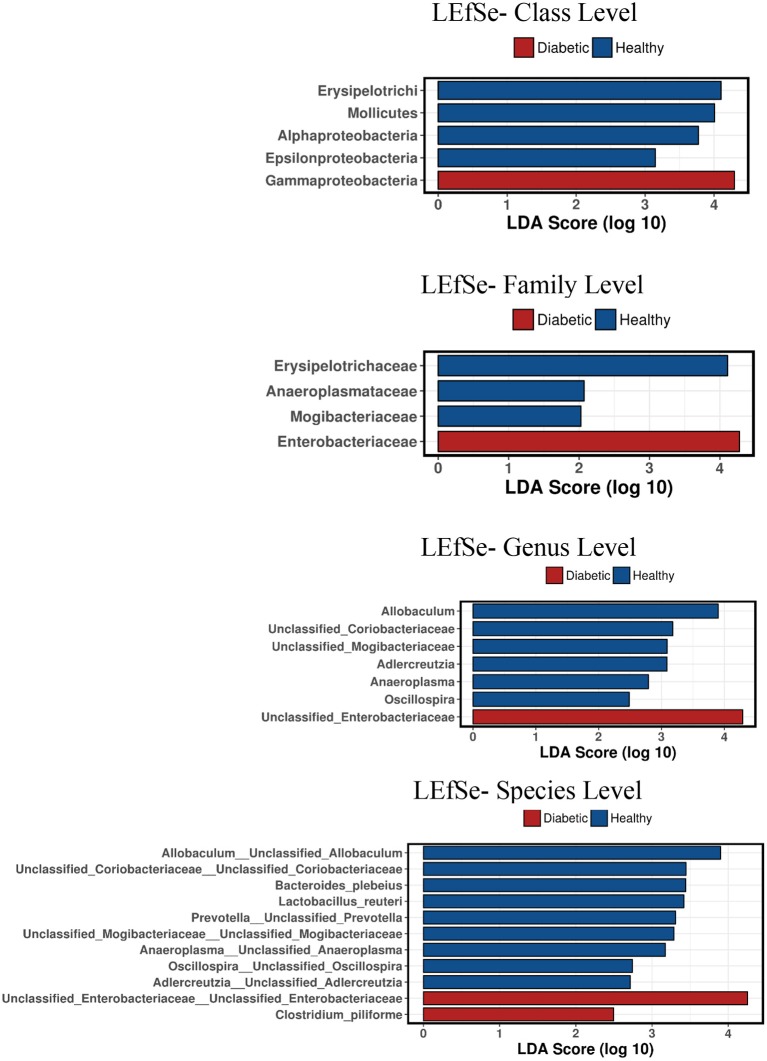
Linear discriminant analysis effect size (LefSe) of bacterial taxa and their association with different canine groups. Only LefSe values >2 are shown.